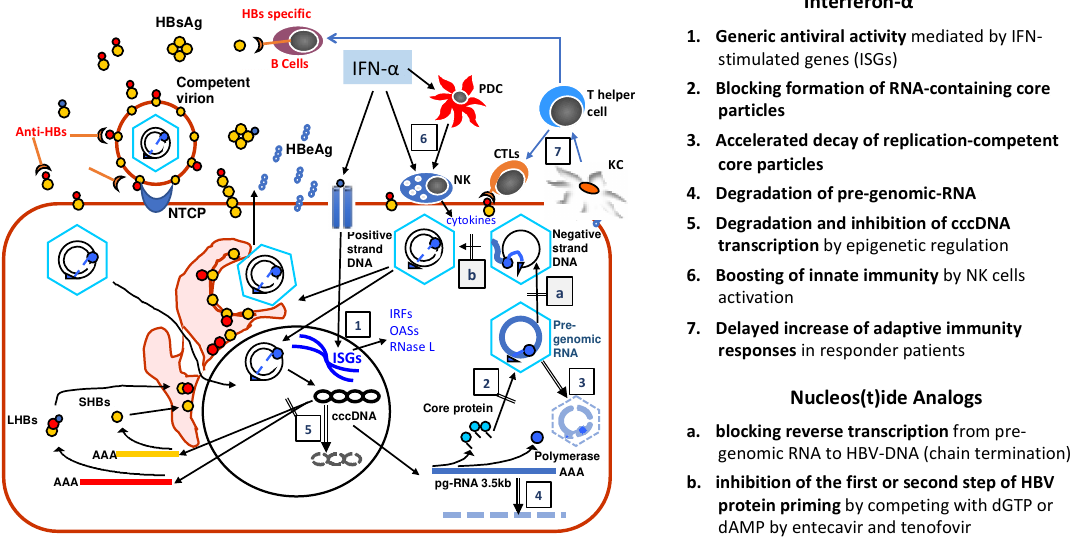
Figure 2. Interferon- α (IFN- α ) has been shown to target different steps of HBV cycle either by generic antiviral mechanisms (1), via activation of the IFN Sensitive Genes (ISGs), or by specific blocking (2) and degrading (3) replication competent core particles, as well as pre-genomic-RNA (4) and nuclear covalently closed circular DNA (cccDNA), or by inhibition of cccDNA transcription (5). The main immune-modulatory activity of IFN- α consists in boosting the innate immune response (6) by stimulating Natural Killer (NK) cells, whereas IFN- α appears unable to restore the effector function of the HBV specific cytotoxic T cells (CTLs). Nevertheless, a late improvement of the adaptive immune responses (7), involving the functions of Kupfer Cells (KC), T Helper lymphocytes and Plasmacytoid Dendritic Cells (PDC), is observed in responder patients. Nucleos(t)ide Analogs (NA) block the RNA- and DNA-dependent DNA polymerase of HBV (a) and causes chain termination during reverse transcription of the pre-genome RNA (pg-RNA) into HBV-DNA. Entecavir and tenofovir also inhibit (b) the first or second step of HBV protein priming by competing with deoxyguanosine triphosphate (dGTP) or deoxyadenosine monophosphate